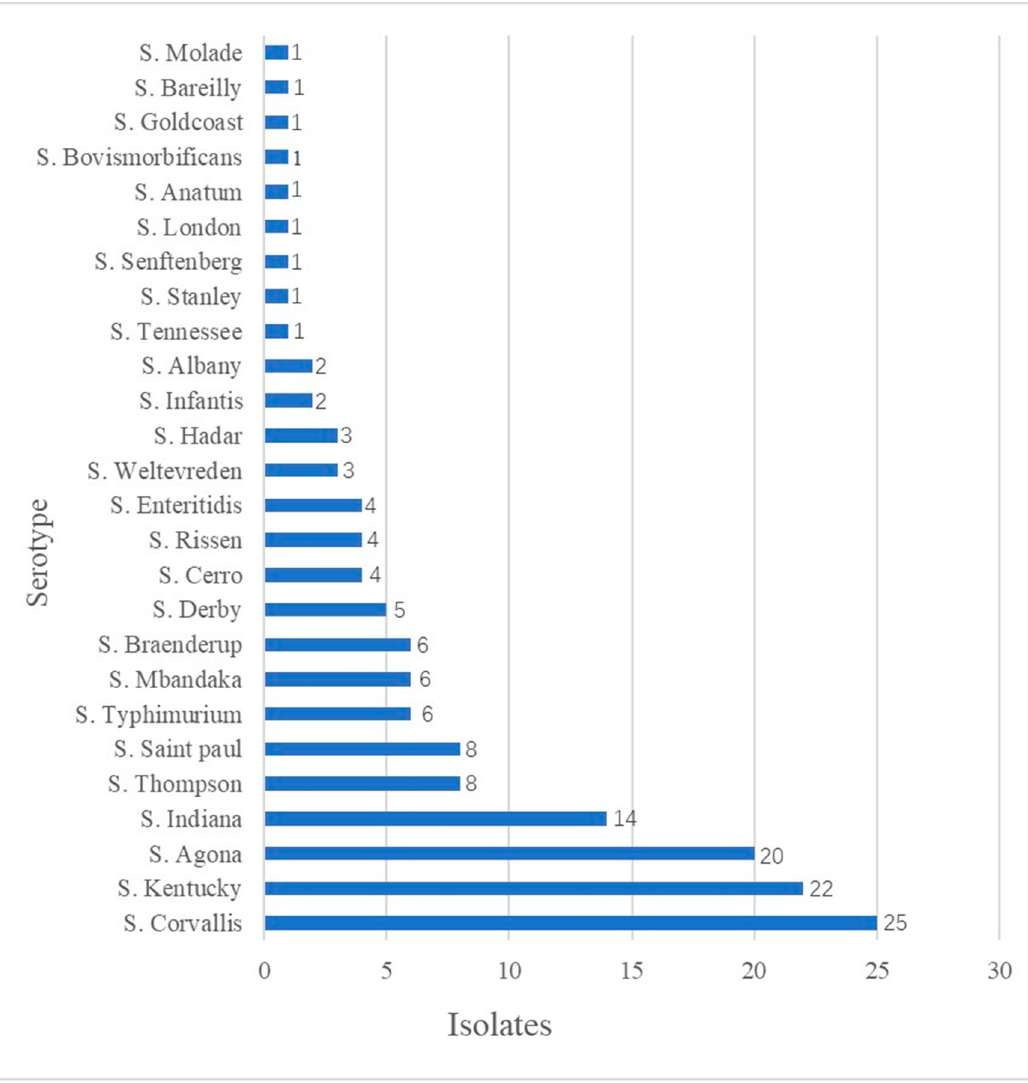
Figure 1. Serotype distribution of Salmonella isolates ( n = 151).